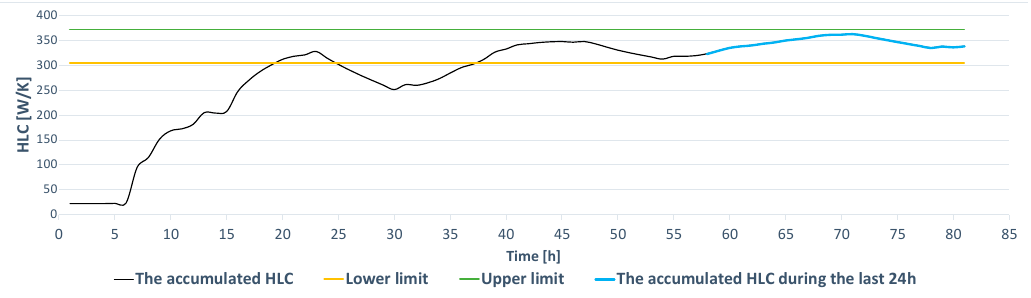
Figure 4. Evolution of the accumulated average of the heat loss coe ffi cient for period 1 in